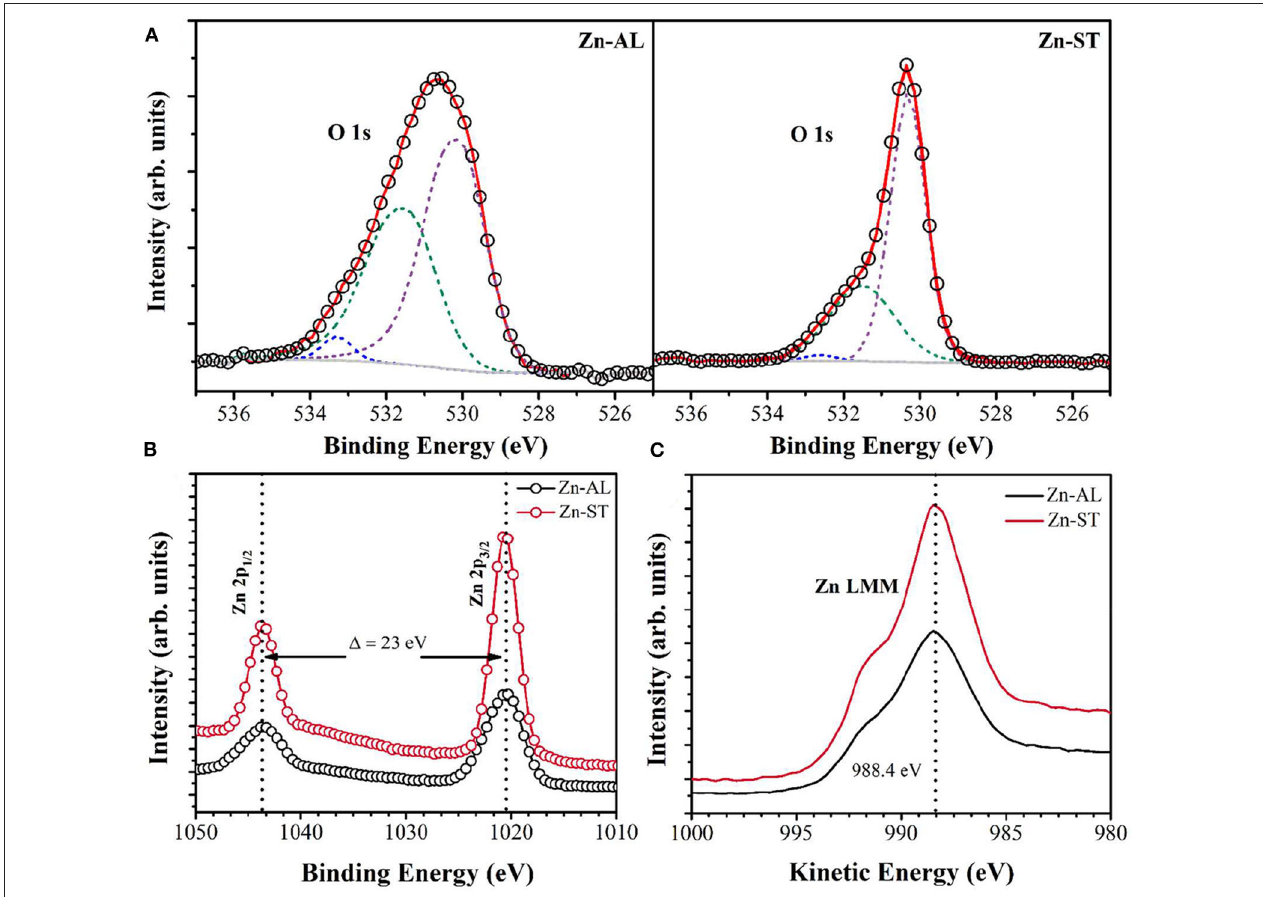
FIGURE 3 | XPS spectra of (A) O 1s. (B) Zn 2p and (C) Zn LMM Auger of the ZnO samples.